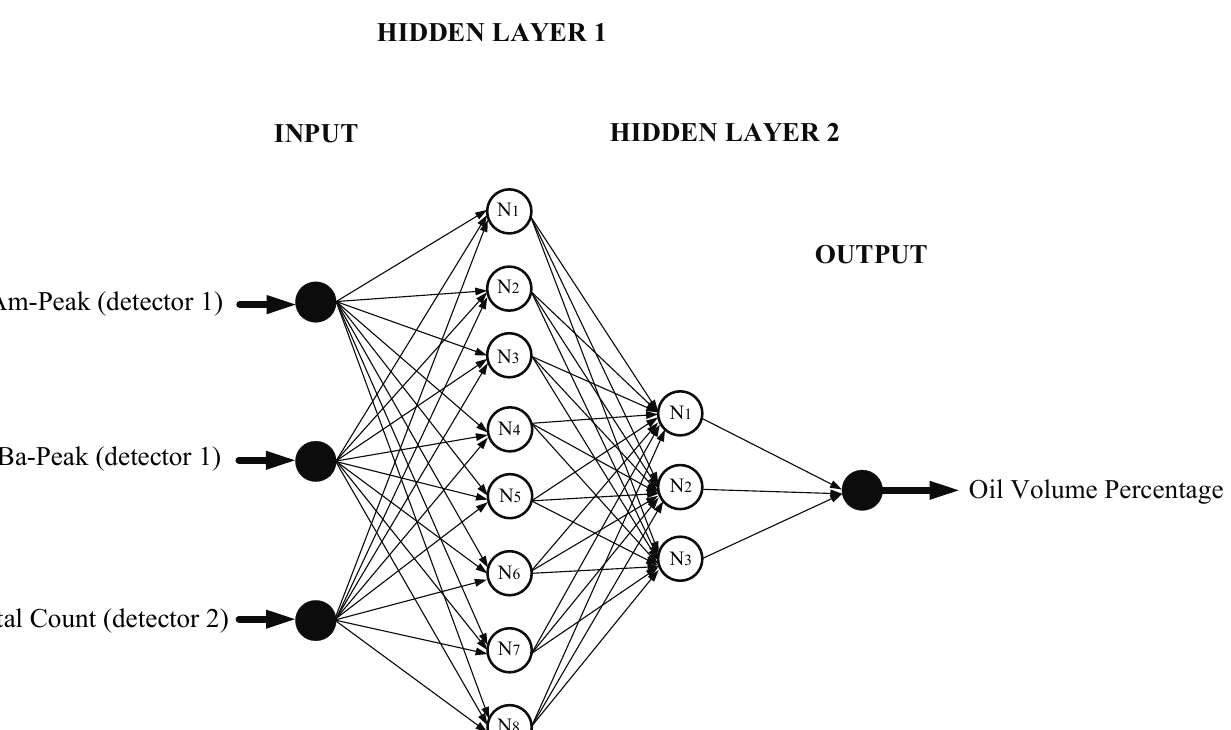
Figure 3. MLP Neural network for predicting gas volume percentage.